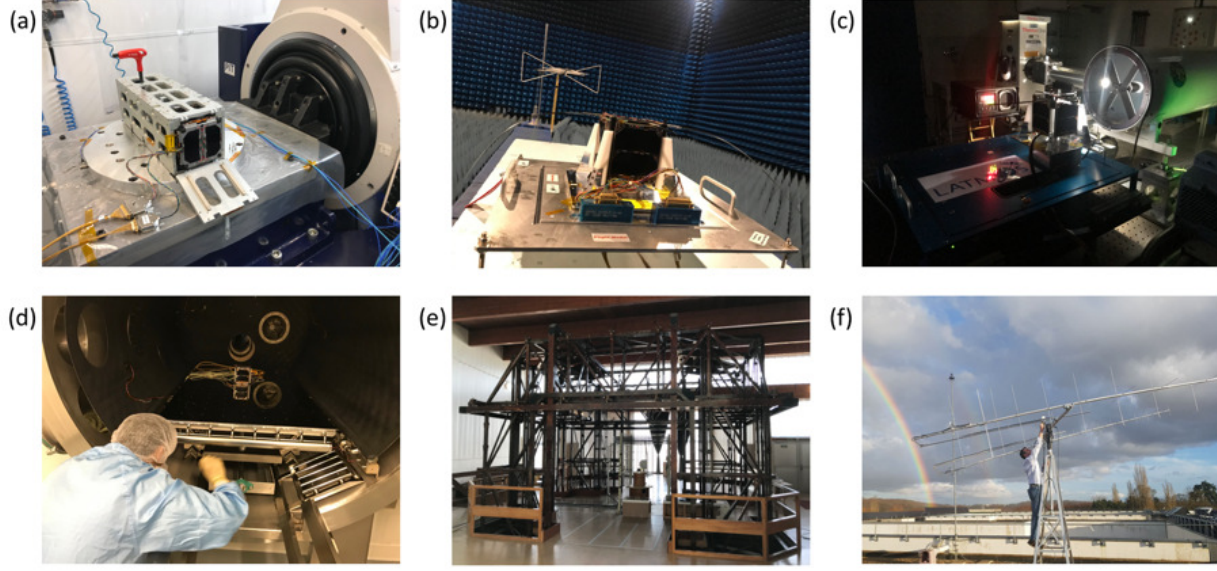
Figure 2. UVSQ-SAT environmental tests and calibrations carried out during the year 2020. ( a ) Vibration. ( b ) EMC tests. ( c ) Calibration with a Xenon lamp and a black body. ( d ) Thermal vacuum and thermal balance tests. ( e ) Magnetic cleanliness verification of the satellite. ( f ) End to end tests with the UHF/VHF LATMOS ground-based station (telemetry at 437.020MHz, telecommand at